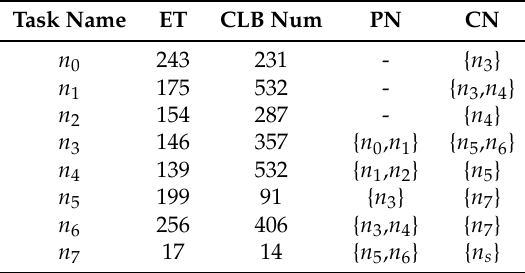
Figure 2. A sample directed acyclic graph (DAG). Table 1. DAG